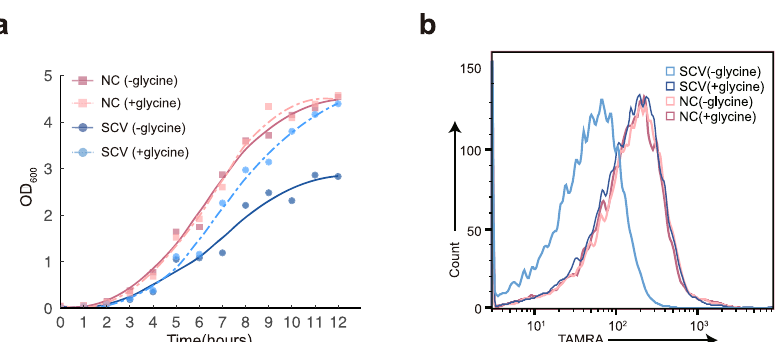
Fig. 4 Effects of exogenous glycine on growth and peptidoglycan-linking rate of S. epidermidis stable SCV. a Growth curves of S. epidermidis stable SCV and its normal counterpart (NC) at 37 °C in either the presence or the absence of 0.2% glycine. LOESS curve fi tting was performed for all data points. Data shown are mean of two biological replicates. b Effects of glycine on peptidoglycan-linking rates of S. epidermidis stable SCV and its NC. Bacterial cells grown in the presence or absence of 0.2% glycine were labeled by TAMRA-bearing FDAA probes over half an hour period and then subjected to fl ow cytometry